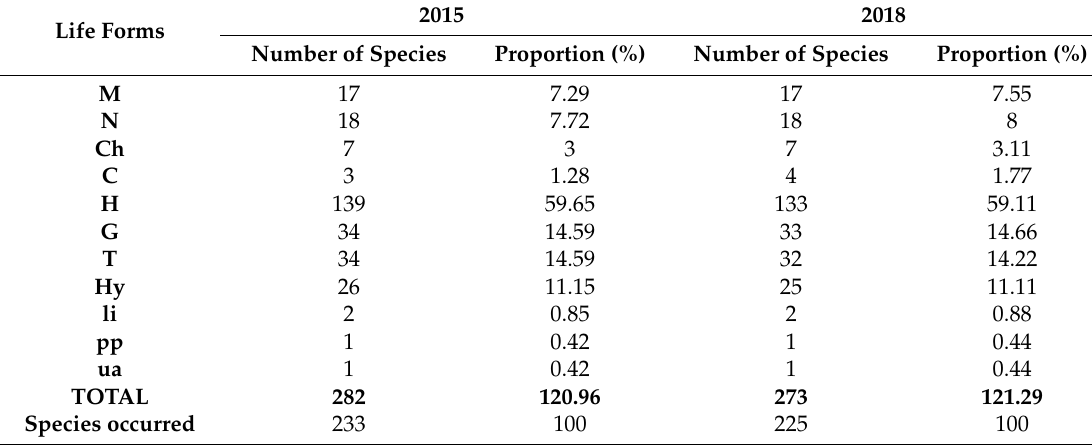
Table 4. Proportions of different plant life forms in the flora of the studied sectors of Lake Piaseczno in 2015 and 2018. M , megaphanerophytes (trees generally growing to a height of more than 5 m); N , nanophanerophytes (shrubs and small trees from 0.5 to 5 m in height); Ch , woody chamaephytes (buds >25 cm above ground); C , herbaceous chamaephytes (buds <25 cm above ground); H , hemicryptophytes (buds at ground level); G , geophytes (buds in soil); T , therophytes (annuals); Hy , hydrophytes and helophytes (buds in water); li , lianas (plants rooted in soil that require support); pp , semi-parasites; and ua , species of undetermined